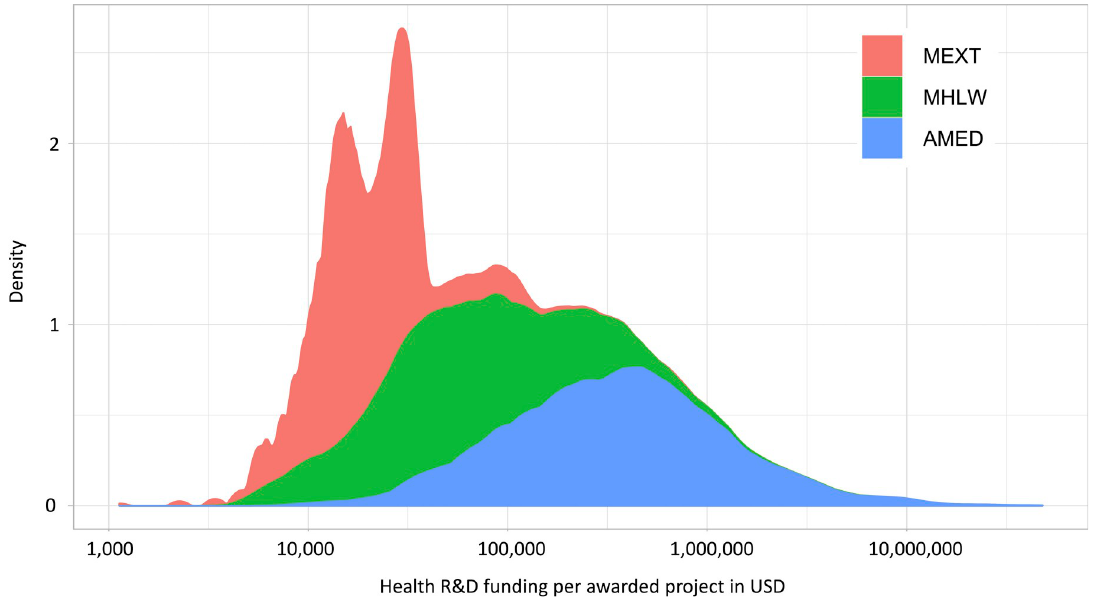
Fig 1. Stacked (Kernel) density plot of health R&D funding per awarded project of each funding system (2015–2016). X-axis is log10 scaled. MEXT: Ministry of Education, Culture, Sports, Science and Technology; MHLW: Ministry of Health and Labour Welfare; AMED: Japan Agency for Medical Research and